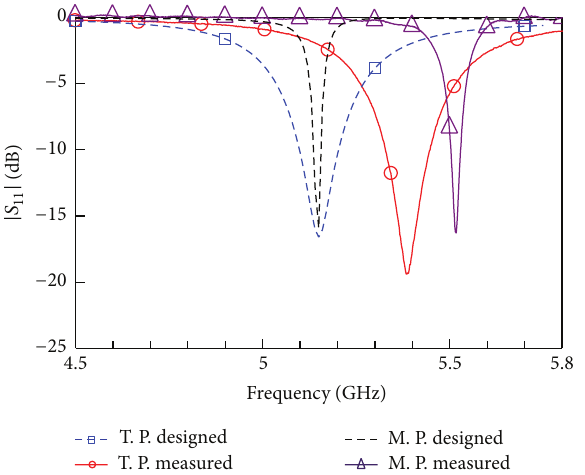
Figure4:Measuredandsimulatedreflectioncoefficientcomparison of traditional antenna with quarter-wave transformer and miniatur- ized antenna with longer feed line.